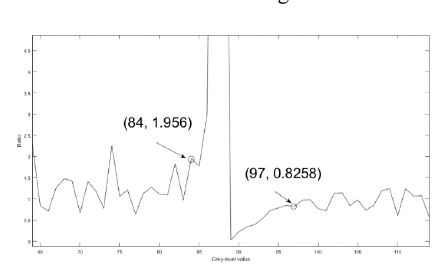
Figure 8. (a) Difference image generated by FDD on Beijing. (b) Curve about the ratio value of adjacent GL on Beijing difference image.